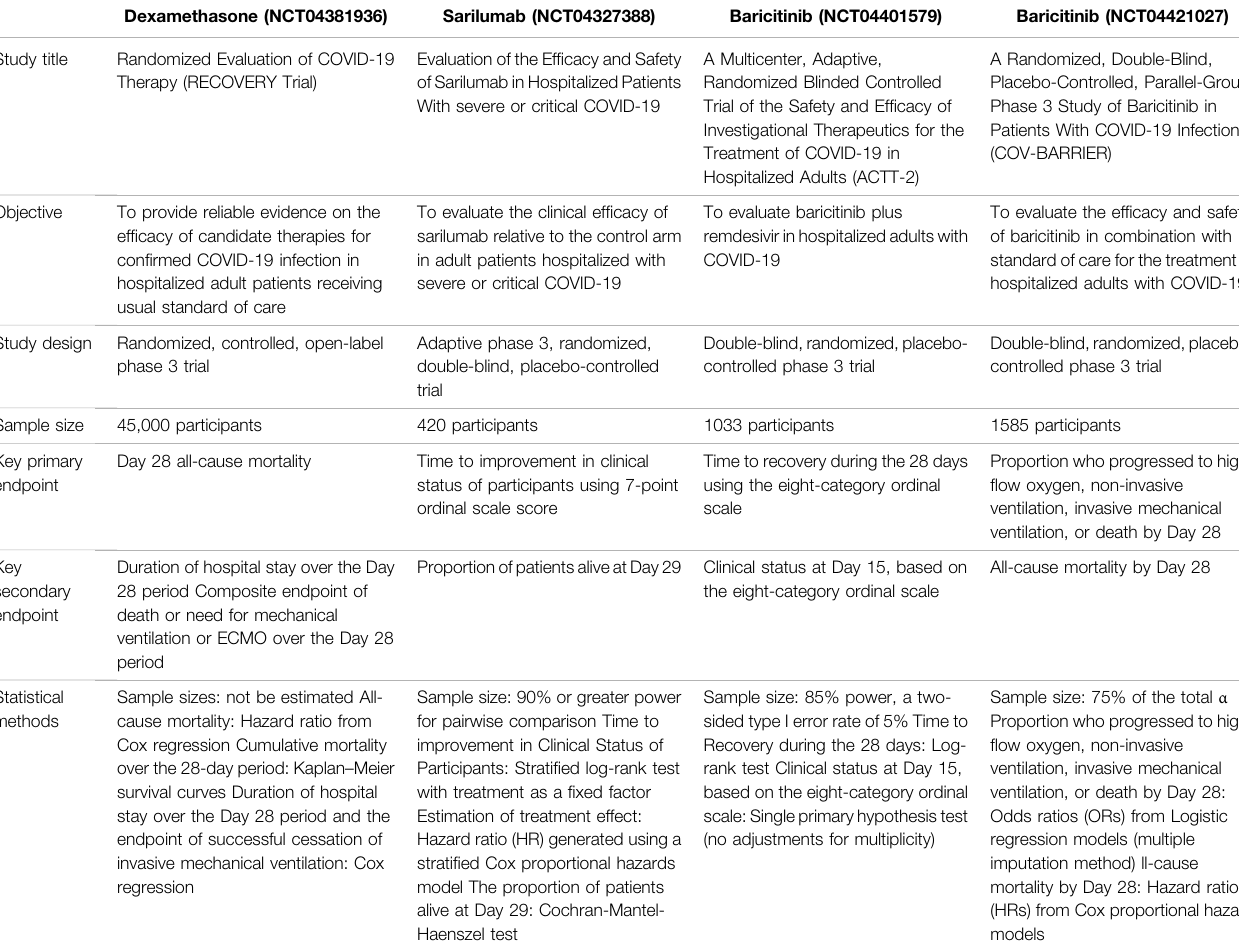
TABLE 2 | Summary of previously conducted clinical trial designs of anti-in fl ammatory